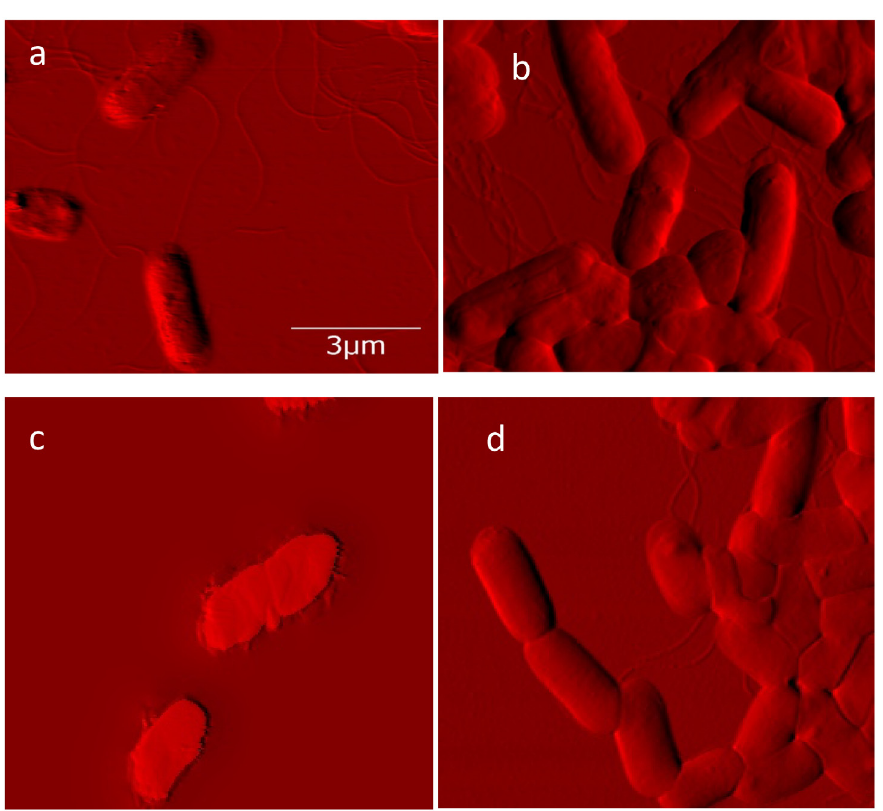
doi:10.1371/journal.pone.0149769.g002